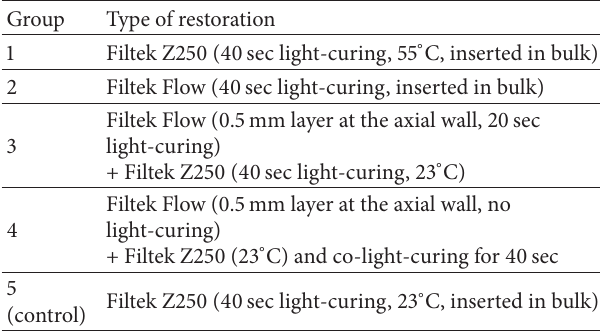
Table 2: The experimental groups of the